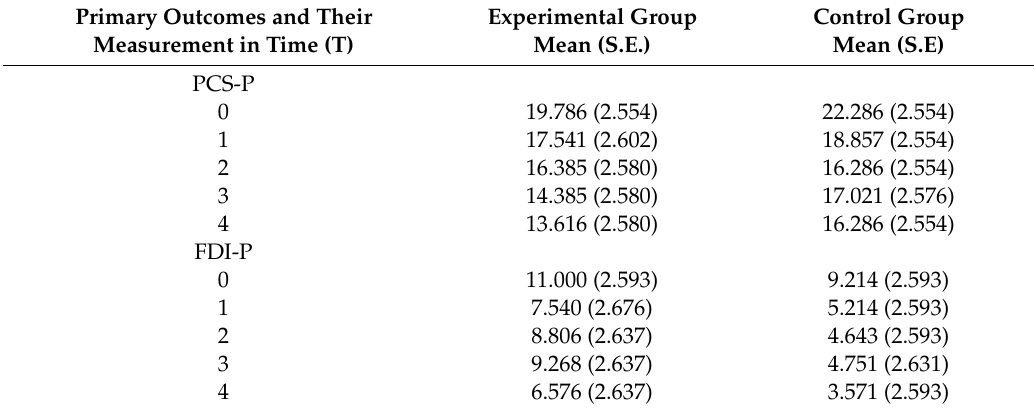
Table 3. Mean and standard error for the interaction e ff ects of the primary outcome measures. Primary Outcomes and Their Experimental Group Control Group Measurement in Time (T) Mean (S.E.) Mean (S.E) PCS-P 0 19.786